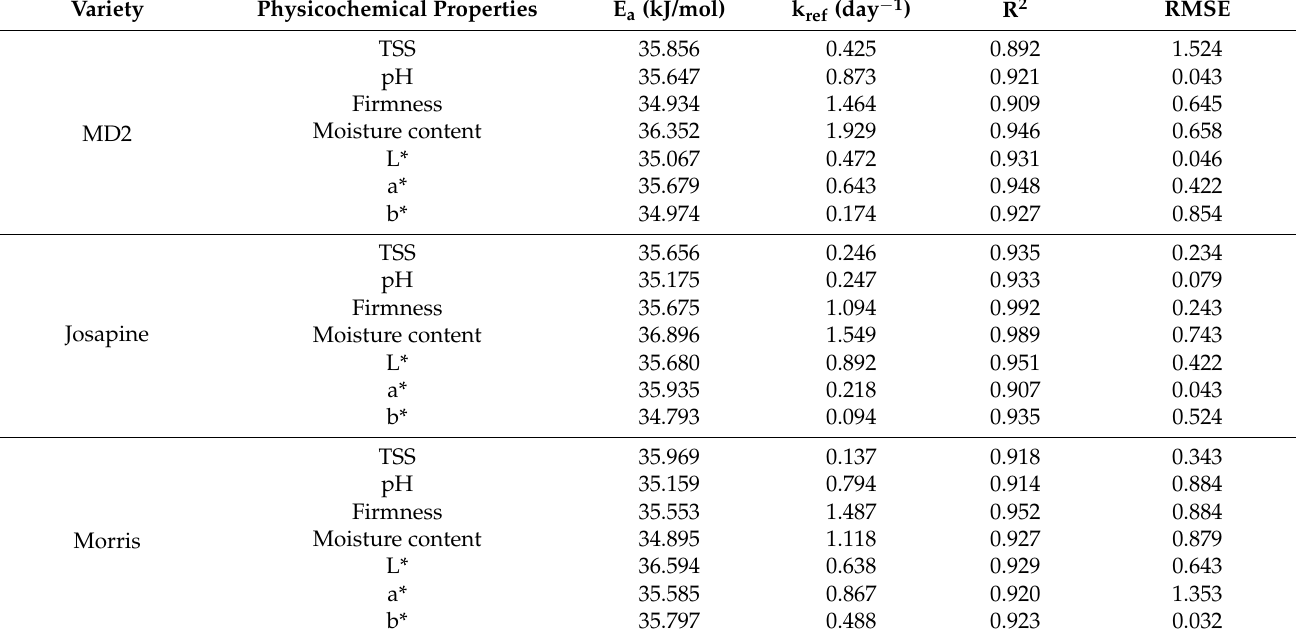
Table 5. Kinetic parameters of physicochemical properties of different pineapple varieties during storage obtained by the Arrhenius